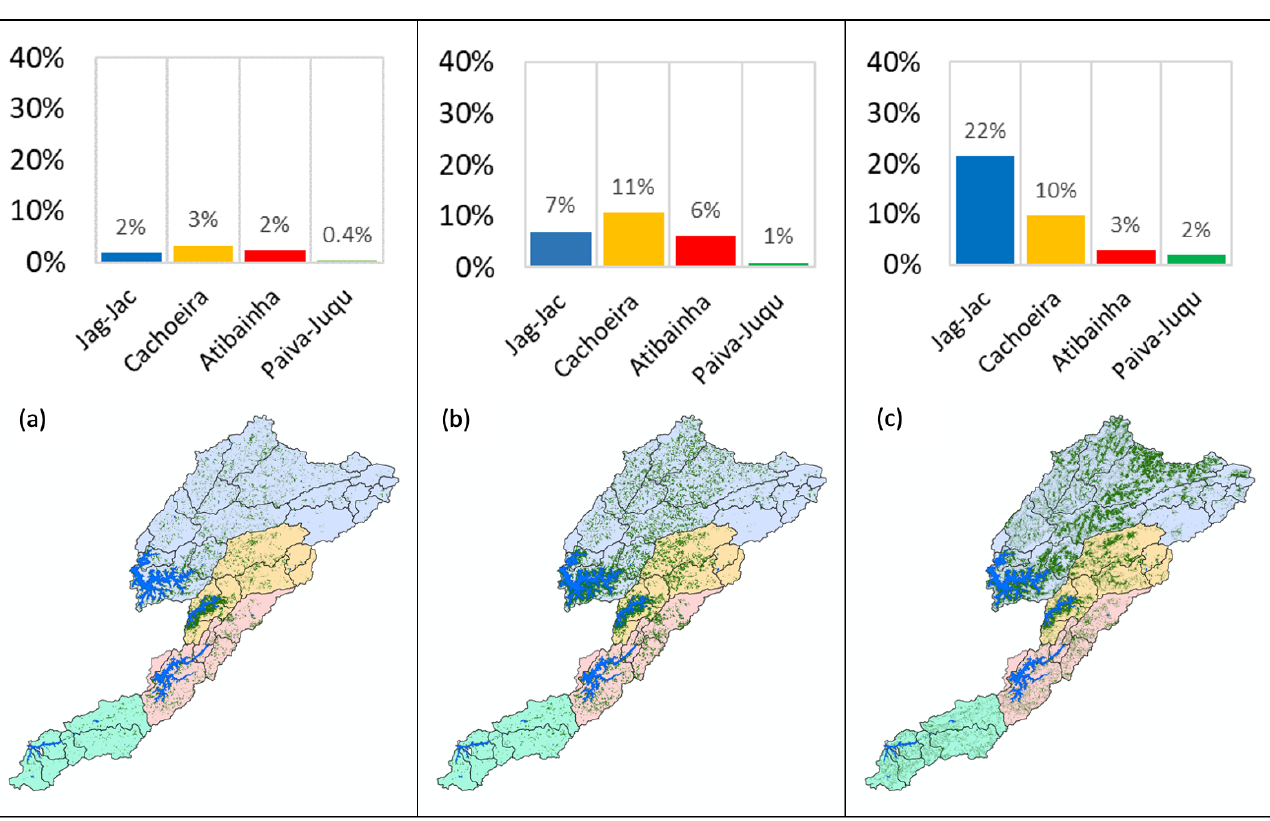
Figure 5. Areas covered (in % of the CWSS extent) by the NbS scenarios (green polygons): ( a ) minimum intervention, ( b ) enhanced intervention, and ( c ) customized RIOS (adopted from Acosta et al. [6] Figure 1).